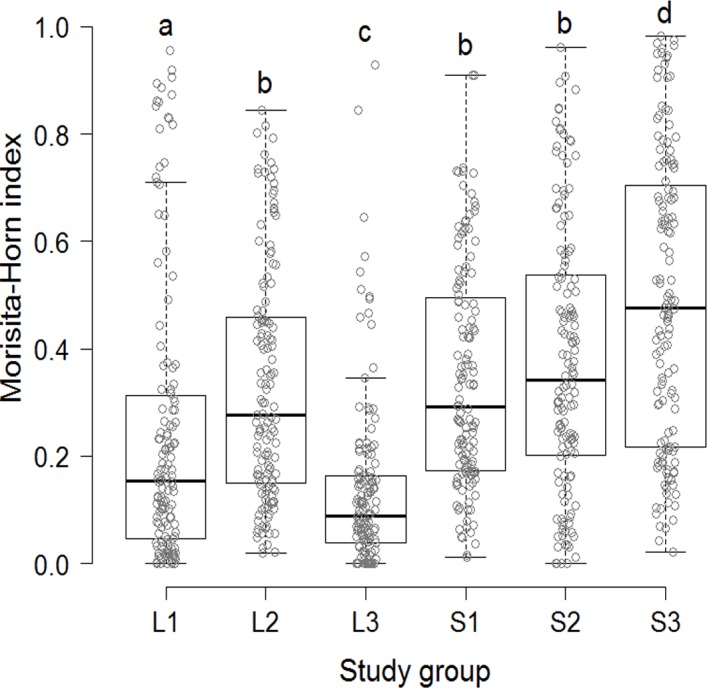
Intermonth diet similarity between study groups inhabiting small and large fragments.The line within a box represents the median of the Morisita-Horn index, the box represents the 25% and 75% interquartiles (IQR), and the whiskers represent the IQR multiplied by 1.5. Dots represent the actual data points for each group. Different letters indicate significant differences (P<0.05).